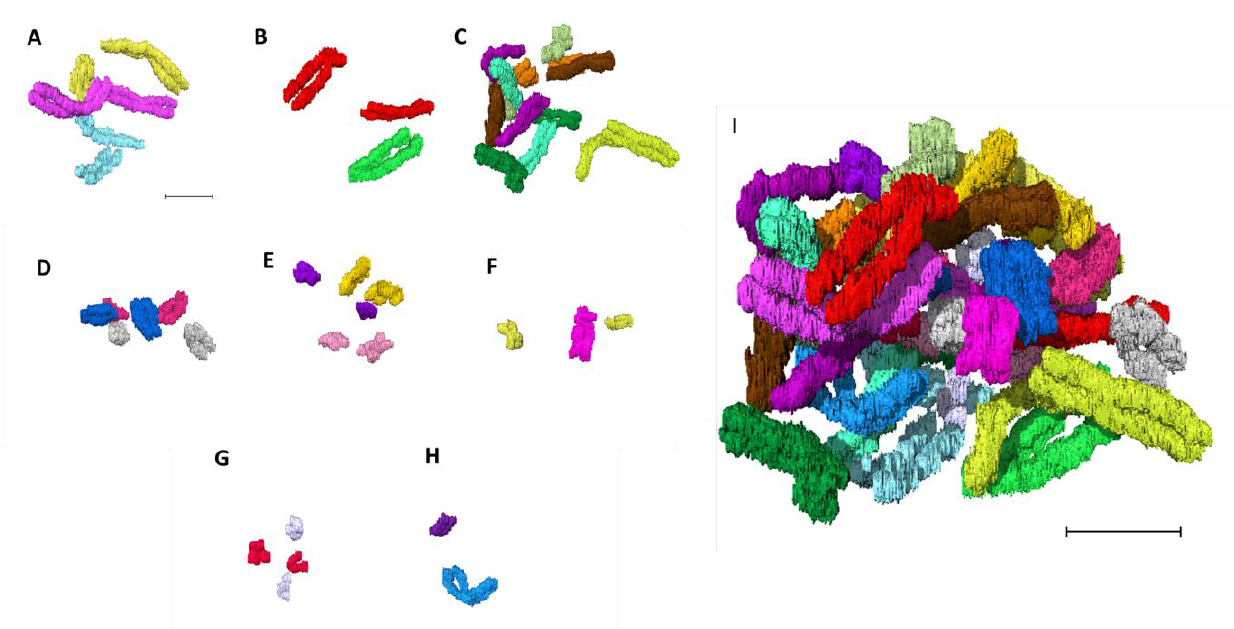
Figure 4. Building the 3D human genome. Chromosomes paired in the same color and classified into eight groups ( A – G (autosomes) and H (sex chromosomes)). ( A ) group A (chromosomes 1–3), ( B ) group B (chromosomes 4 and 5), ( C ) group C (chromosomes 6–12), ( D ) group D (chromosomes 13–15), ( E ) group E (chromosomes 16–18), ( F ) group F (chromosomes 19 and 20), ( G ) group G (chromosomes 21 and 22), ( H ) group H (sex chromosomes X and Y), ( I ) 46 chromosomes making the human genome after assembling A–H. Scale bar—2 µm.